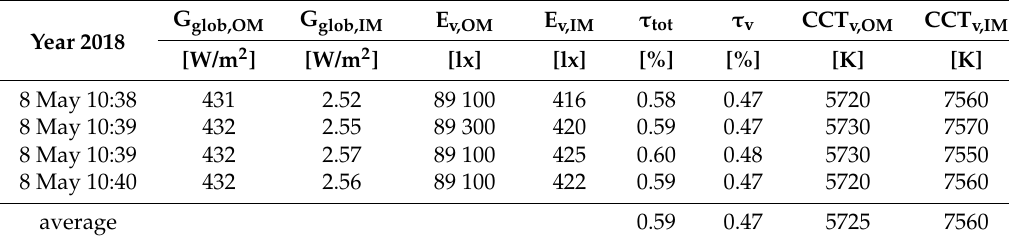
Table 4. Measurement of the illuminance for the (visual) light transmittance τ v